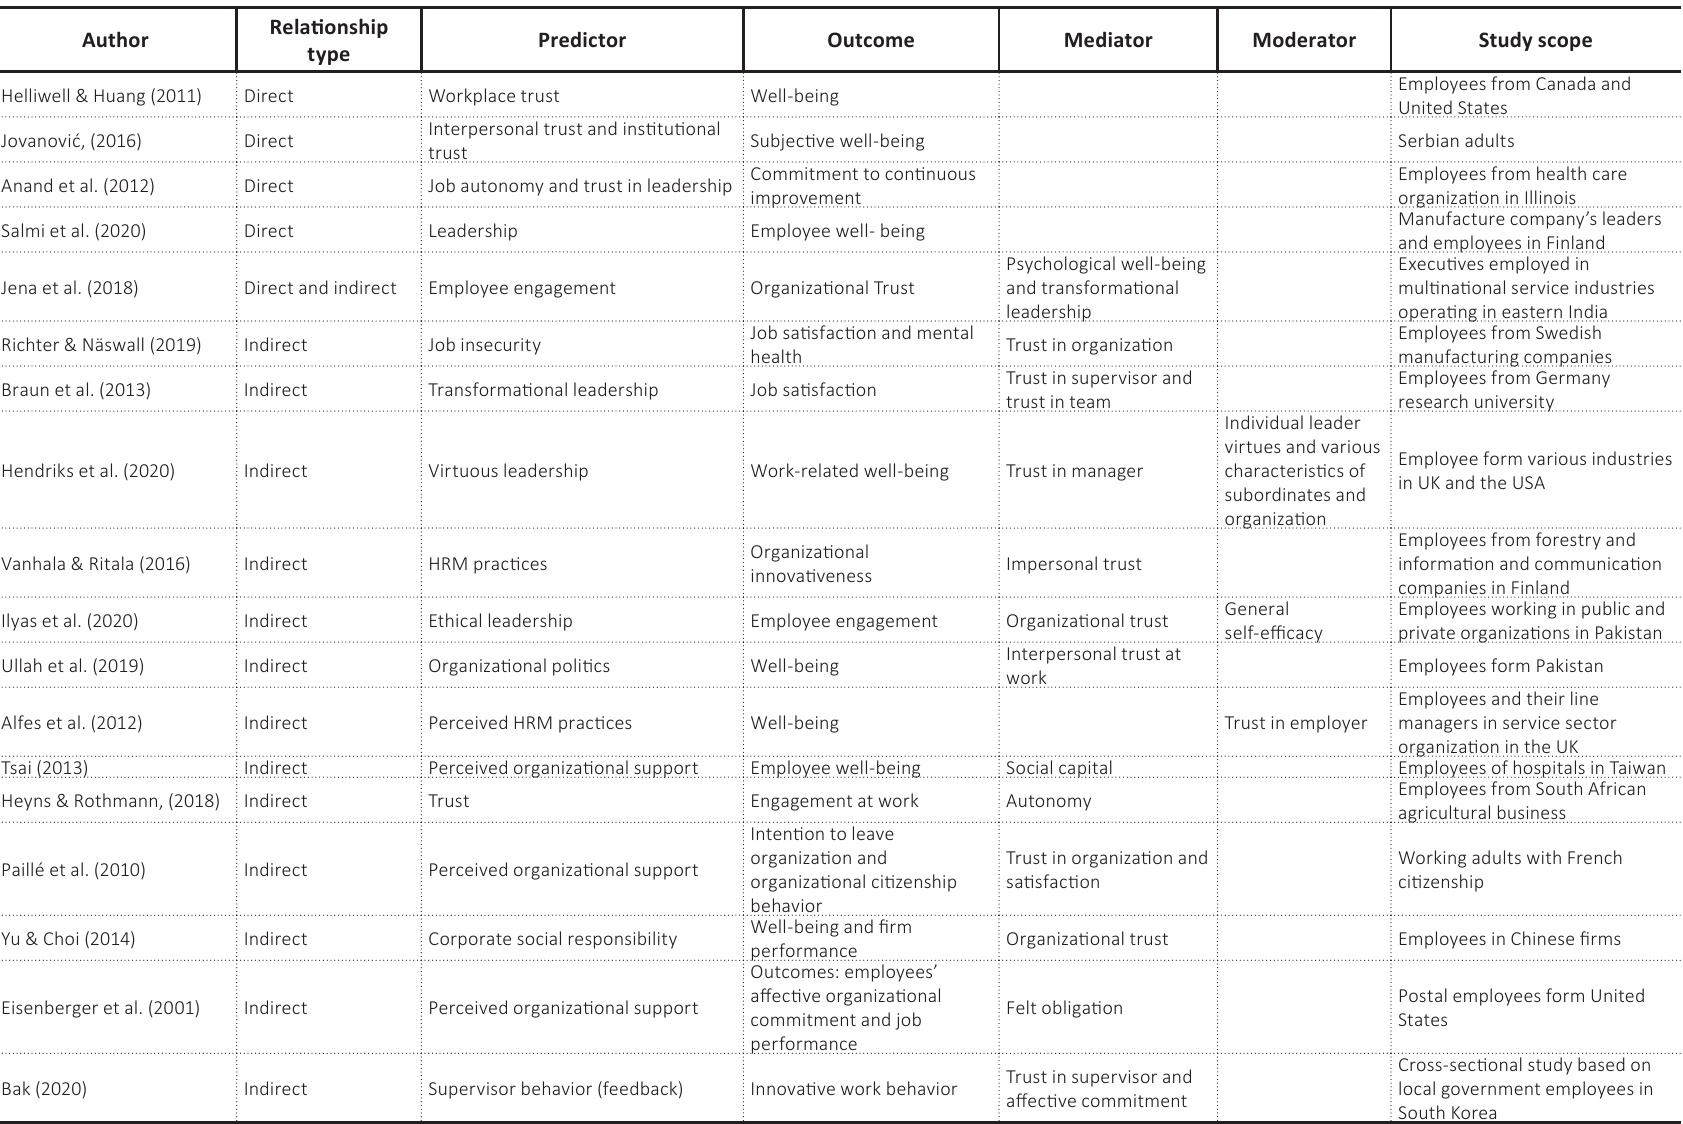
Source: Composed by the